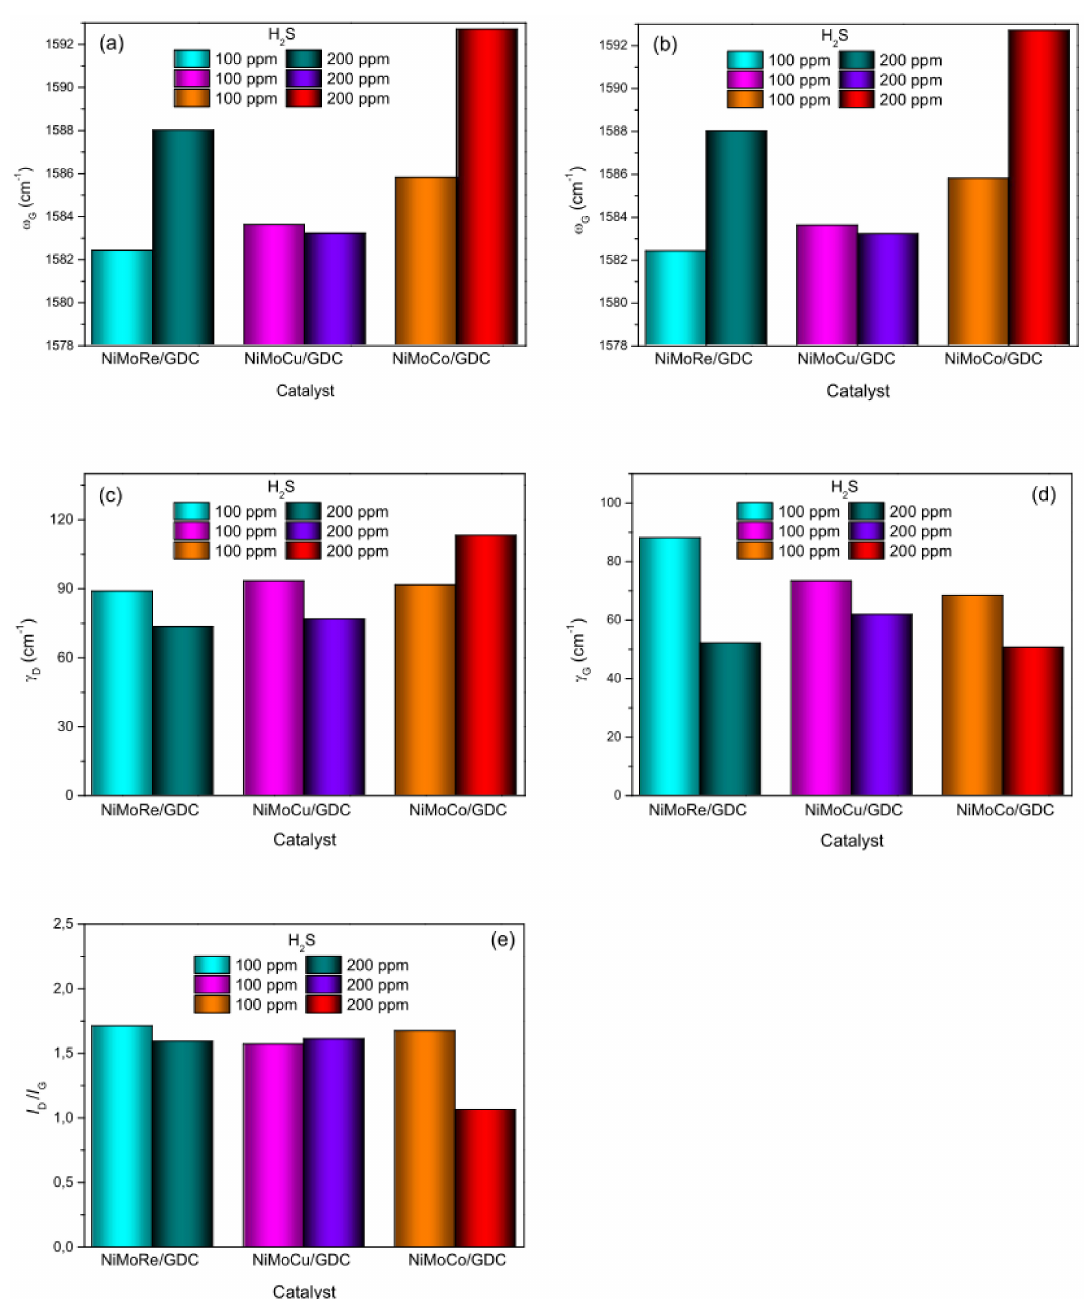
Figure 13. ( a , b ) Center frequencies ( ω D and ω G ) and ( c , d ) widths ( γ D and γ G ) of the D- and G-bands and ( e ) D/G intensity ratio ( I D / I G ) in the investigated catalysts for different H 2 S